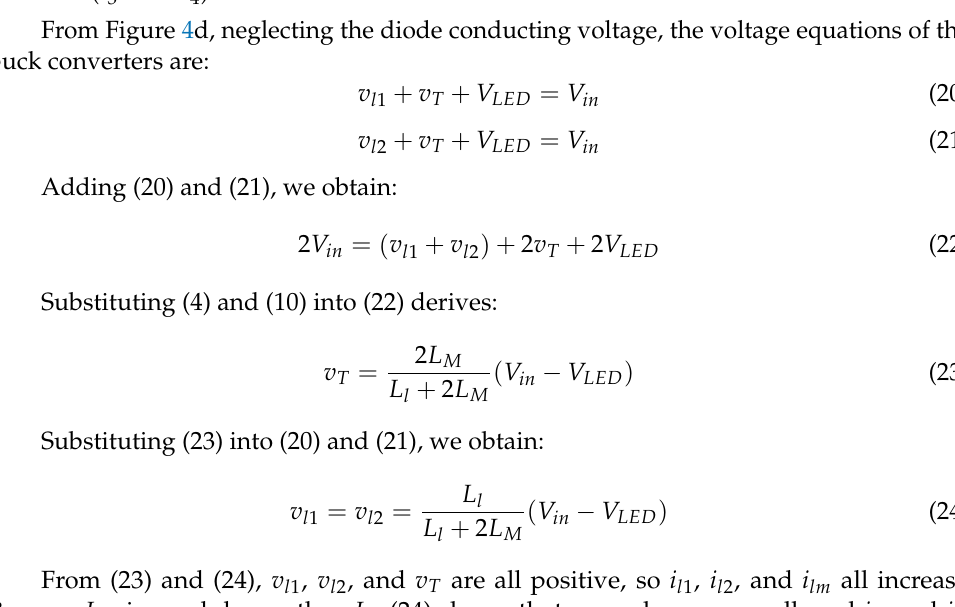
Figure 4f–j represents the equivalent circuits of operating modes VI to X,